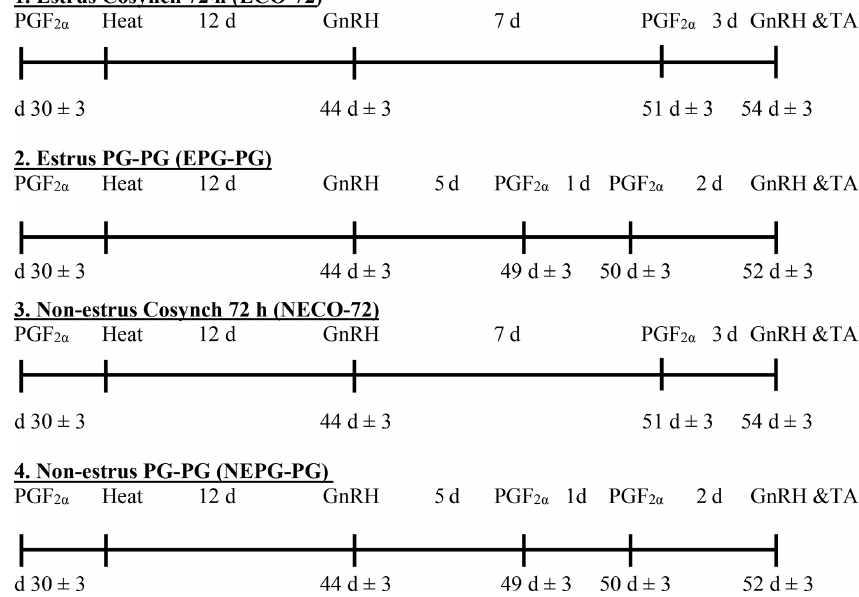
Average milk production between days 30 and 90 pp was 28 . 4 ± 0 . 5 kg d − 1 , and the average in the first 120 d pp was similar ( P ≥ 0 . 05) for cows in the EPG–PG, NEPG–PG, ECO-72 and NECO-72 treatments (27 . 9 ± 0 . 5, 28 . 1 ± 0 . 4, 28 . 6 ± 0 . 5 and 28 . 5 ± 0 . 4 kg d − 1 , respectively) and did